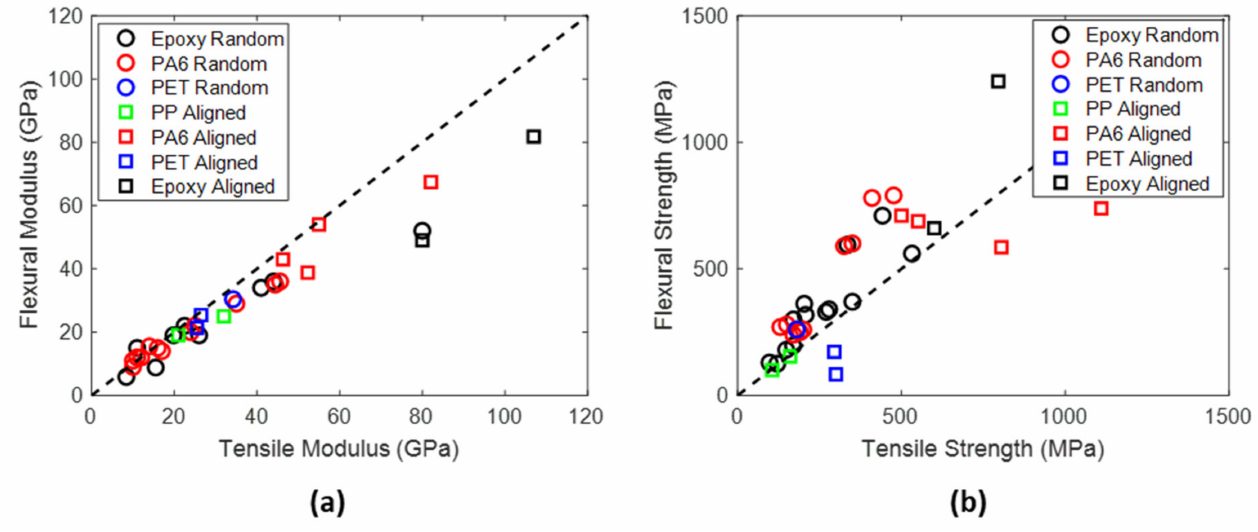
Figure 13. Comparison of tensile and flexural modulus ( a ) and strength ( b ) of recycled carbon fiber composites from literature [26,27,29,30,43,49,51,54,65,67,72,77,80,85,86]. Dashed line represents one-to-one